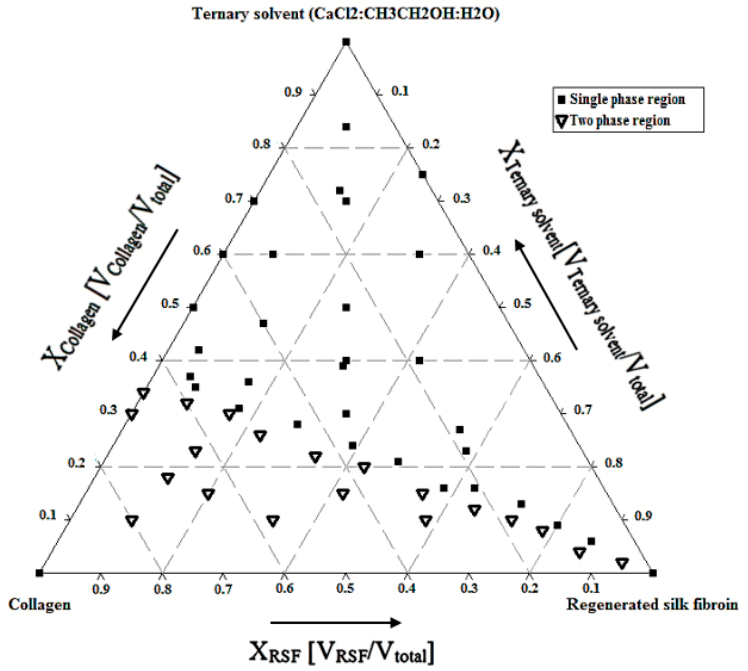
Figure 1. Ternary phase diagram of collagen/RSF/ternary solvent at 4 °C.